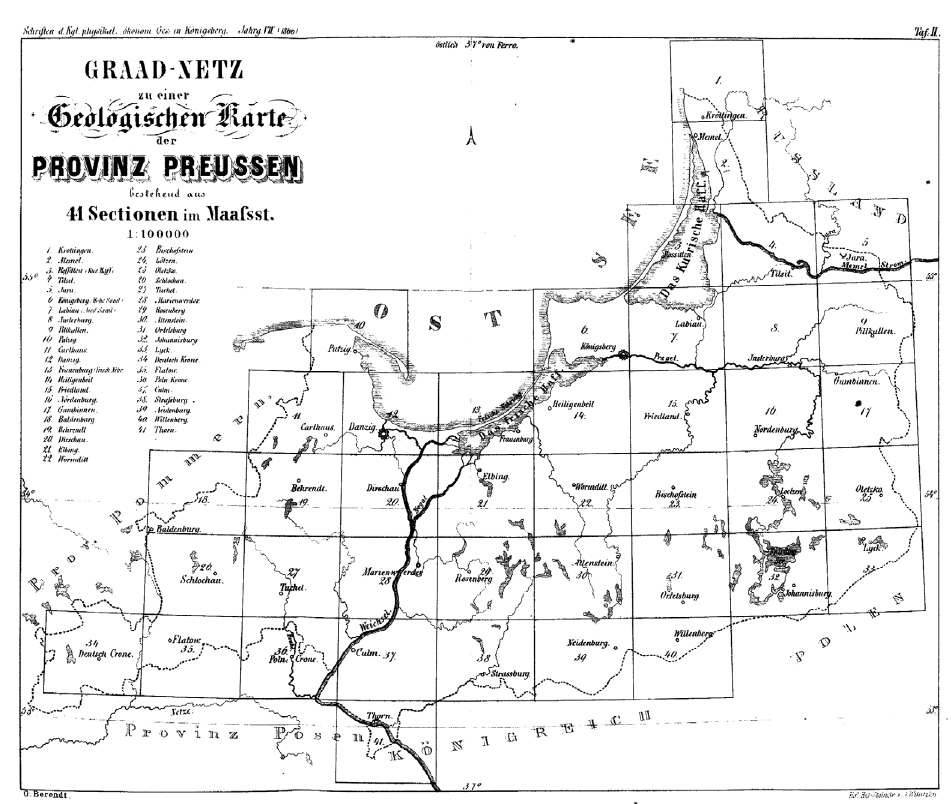
Fig. 1. Section map of planned sheets of the Geological Map of the Prussia Province at the